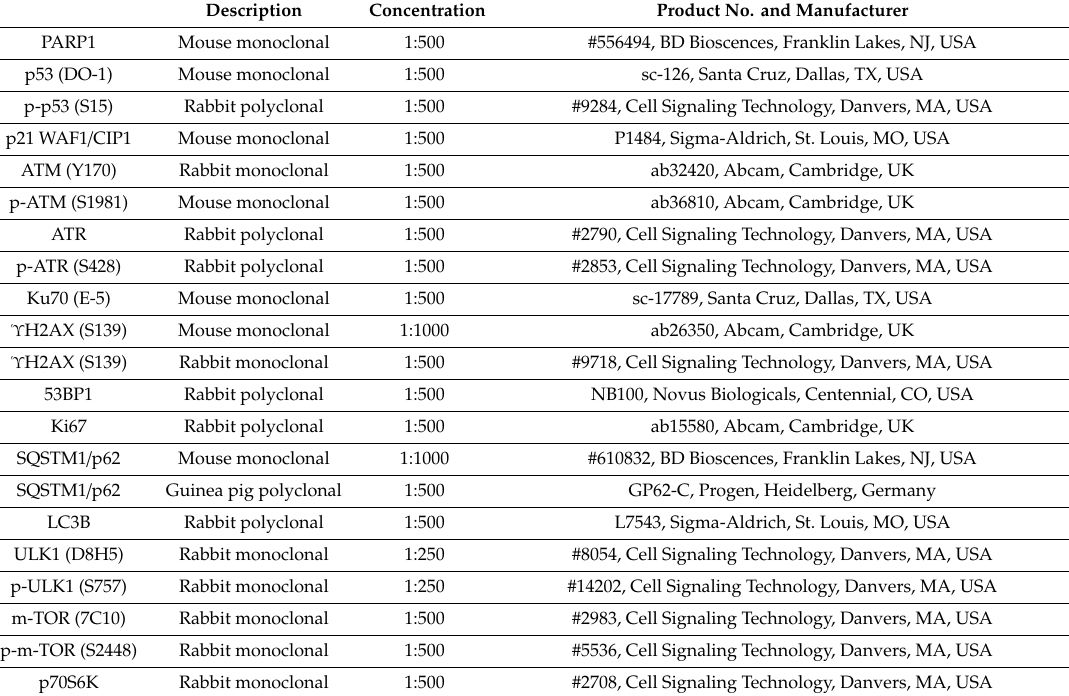
Primary antibodies are listed in Table 1. Secondary antibodies: anti-rabbit Alexa 488, anti-mouse Alexa 488, anti-rabbit Alexa 555, anti-mouse Alexa 555 from Life Technologies, (Carlsband, CA, USA), (1:500; A11008, A110296, A21428 and A21422) and anti-guinea pig Alexa 594 from Jackson ImmunoResearch (Cambridgeshire, UK), (1:500; 103-605-155). Table 1. Primary antibodies used in the study.